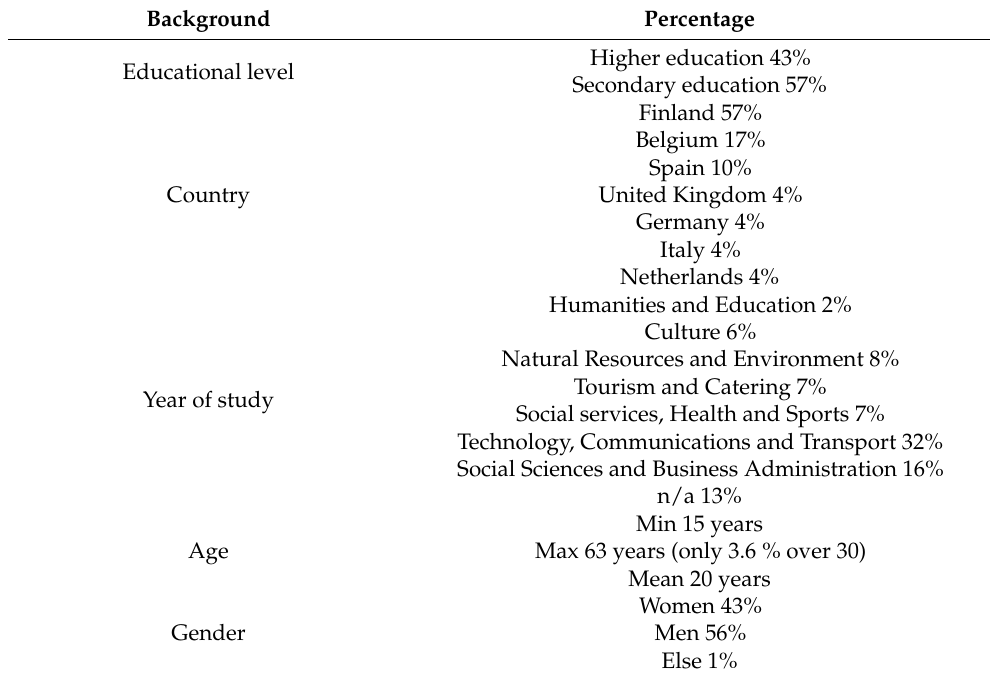
Table 1. Background characteristics of the